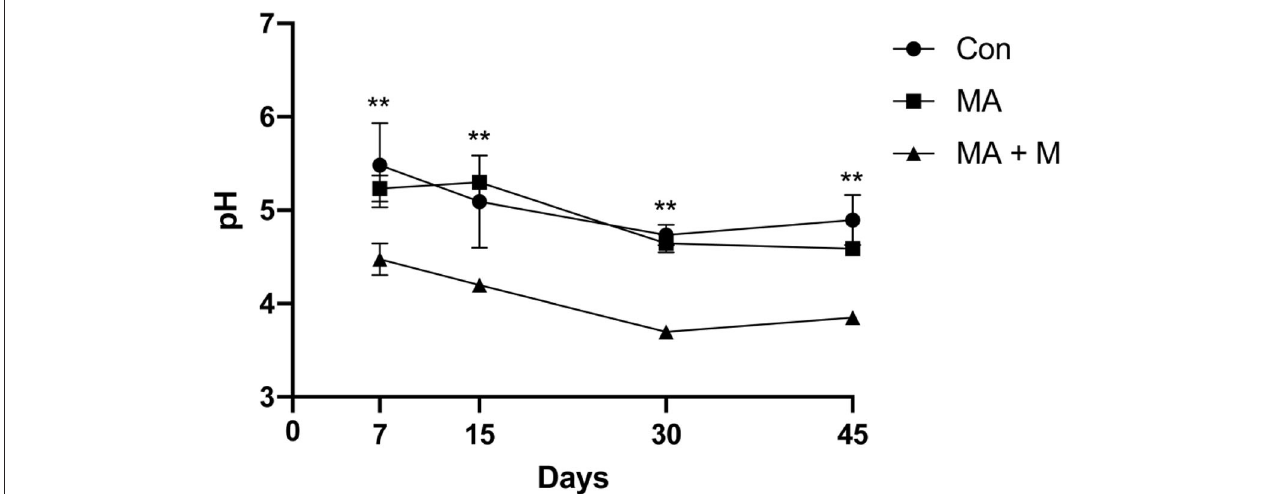
FIGURE 4 | The effect of MA pretreatment on the pH value of rice straw. Con, no additive, control; MA, added microecological agents; MA + M, a combination of microecological agents and molasses. ** indicate the significant correlations at P < 0.01.